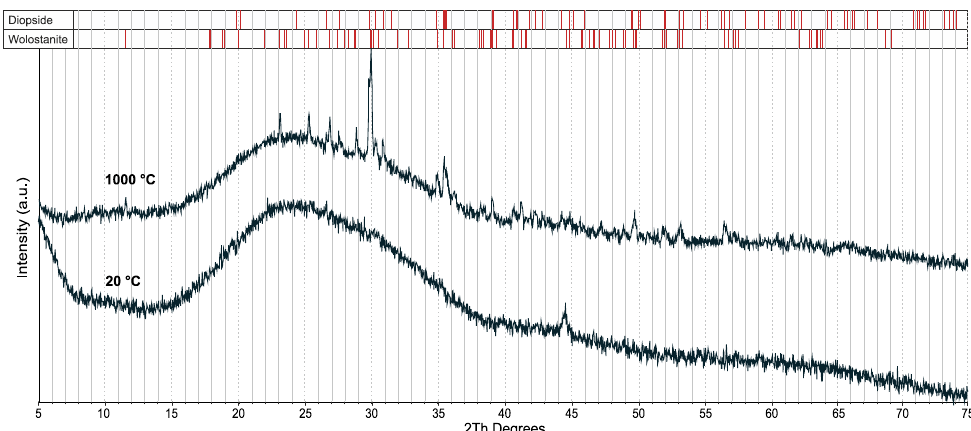
Figure 5. XRD pattern of the glass cullet (GC) (bottom curve) and GC treated at 1000 °C (upper curve).